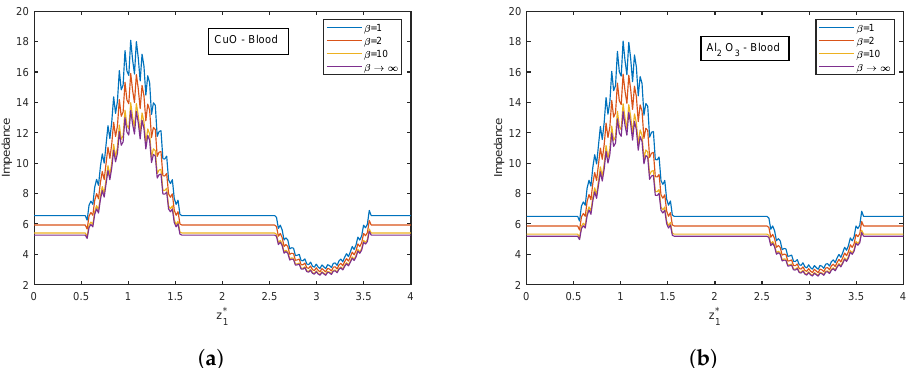
Figure 28. Impedance profiles of Casson fluid parameter β for ( a ) CuO-nanoparticles, ( b ) Al 2 O 3 - nanoparticles at t ∗ = 1.2. 1